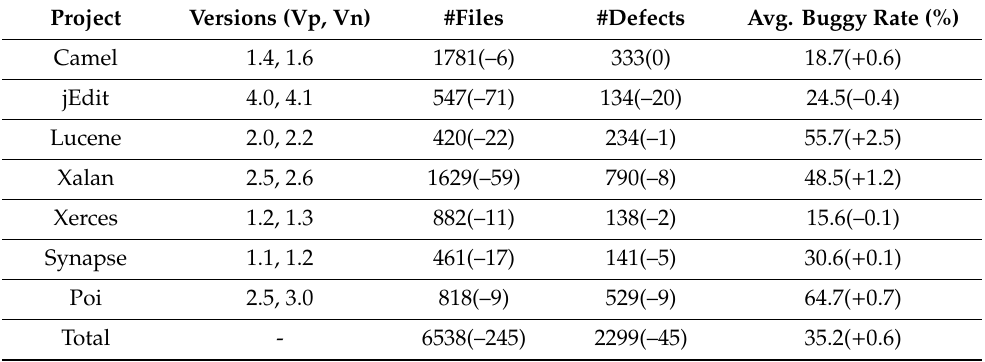
Table 2. Simplified PROMISE Source Code (SPSC) dataset description. SPSC is applied for cross-version within-project defect prediction (WPDP). Numbers in brackets indicate numeral changes compared with the original dataset from PROMISE